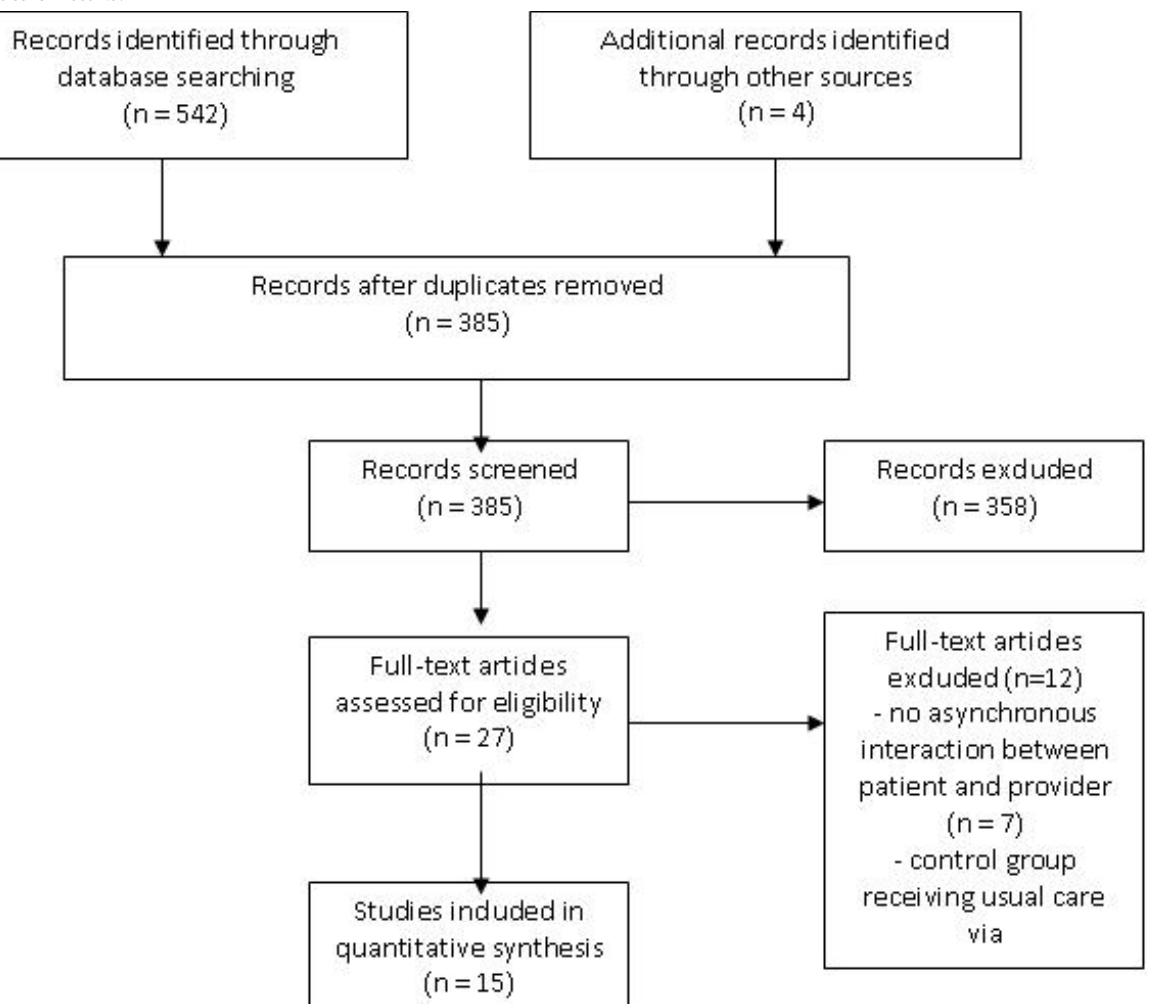
Figure 1. Search